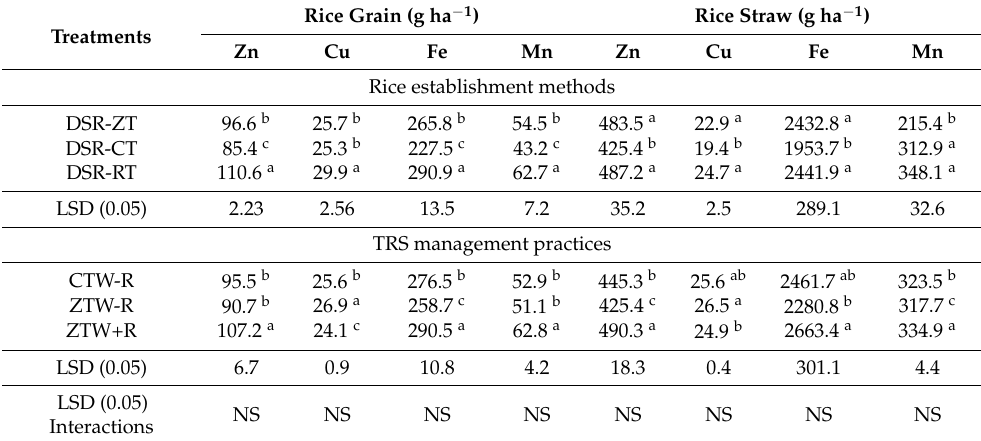
Table 5. Removal of micronutrients (g ha 1 ) by rice grain and straw under different rice establishment methods. Treatments